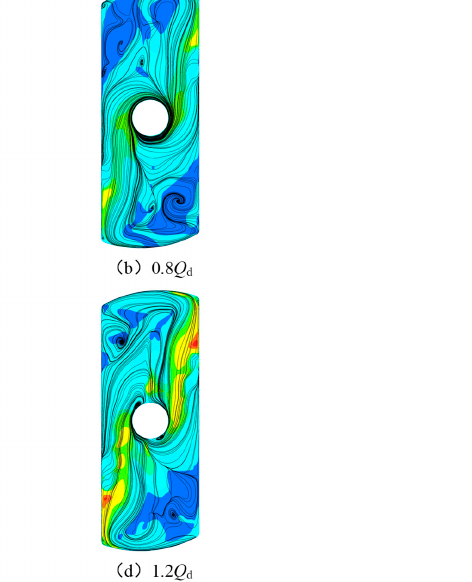
Figure 6. Velocity distribution on the mid-span of the back channel under different flow rates.